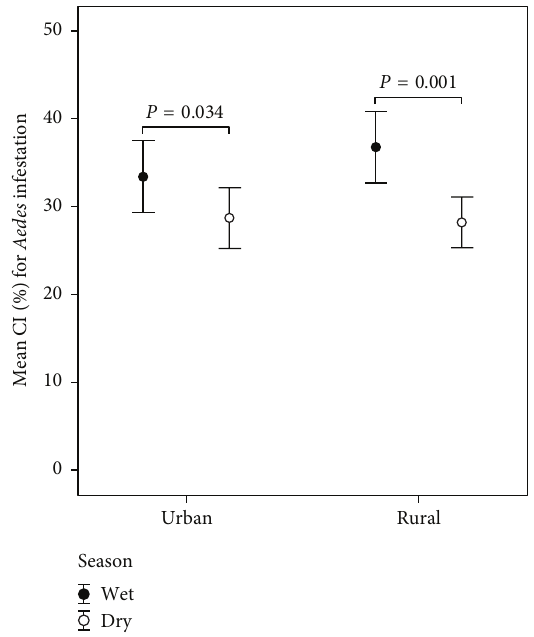
Figure 4: Comparisons of the Aedes -producing containers in the infested households of the urban and rural settings by season. Mean percentages ( ± 2 SE) of CI values as denoted by error bars were presented between two study settings. The statistical significance with the Mann-Whitney 𝑈 test ( 𝑃 < 0.05 ) is shown for two categorical seasons on the distributions of Aedes larva